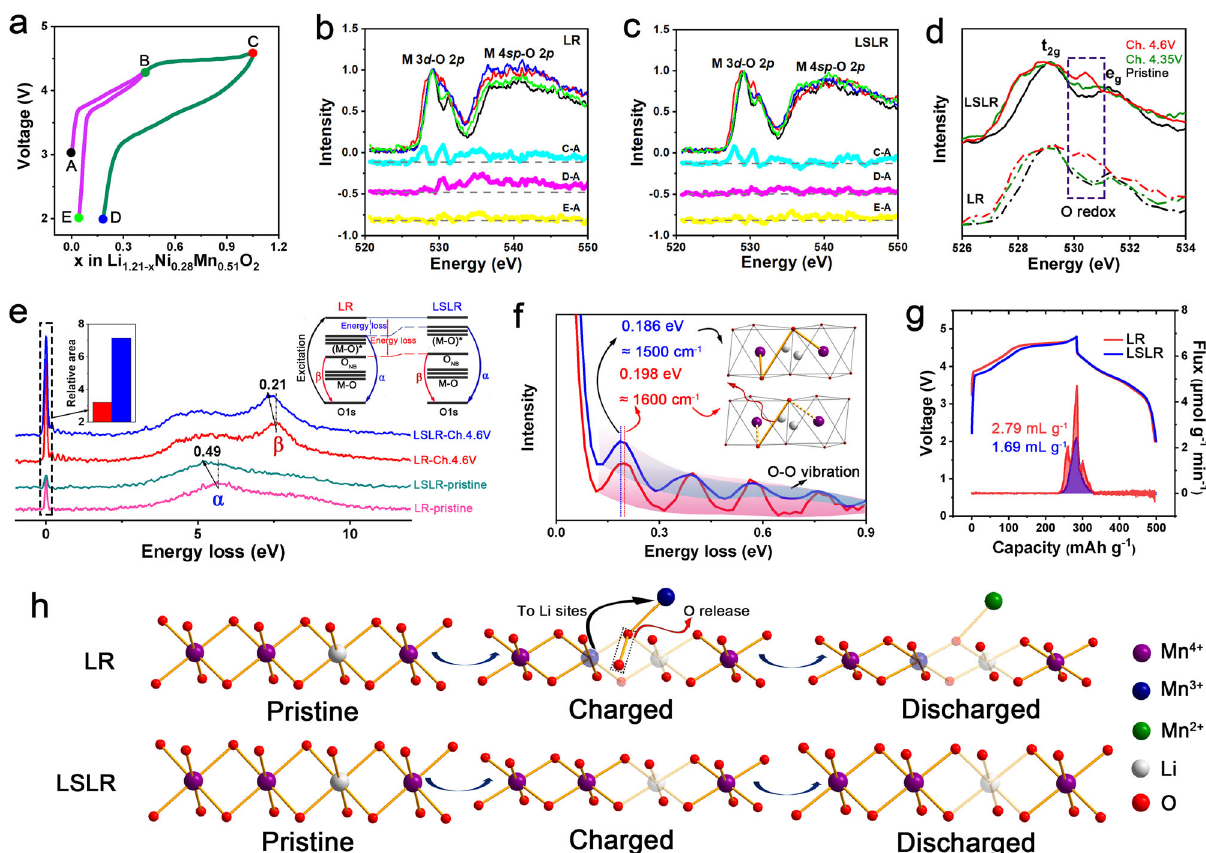
Fig. 4 Oxygen redox behaviors in LR and LSLR. a The electrochemical state selection for collecting XAS spectrum. b , c The normalized O – K-edge spectra and the spectra difference between two designated points in the electrochemical curve for LR ( b ) and LSLR ( c ). Black represents the pristine state, dark green represents the 4.35-V charged state, red represents the 4.6-V charged state, blue represents the 2.0-V discharged state with a 4.6-V upper limit, and light green represents the 2.0-V discharged state with a 4.35-V upper limit. d The normalized pre-K-edge peaks of lattice oxygen. Ch. is short for charge. e The normalized O – K-edge RIXS for pristine and 4.6-V charged LR and LSLR electrodes. The insets declare the corresponding RIXS process and the relative elastic peak area of the two materials, setting the elastic peak area of each sample in the pristine state as 1. f Enlarged image in ( e ) at energy loss from 0 to 0.9 eV for the O – O vibration. The insets depict the schematic interaction between generated O – O species and Mn cations in bulk lattice. g Operando differential electrochemical mass spectrometry (DEMS) of O 2 evolution rate during the initial cycle. h Sketch for illustrating cation migration and oxygen release in LR and LSLR. Source data are provided as a Source Data fi